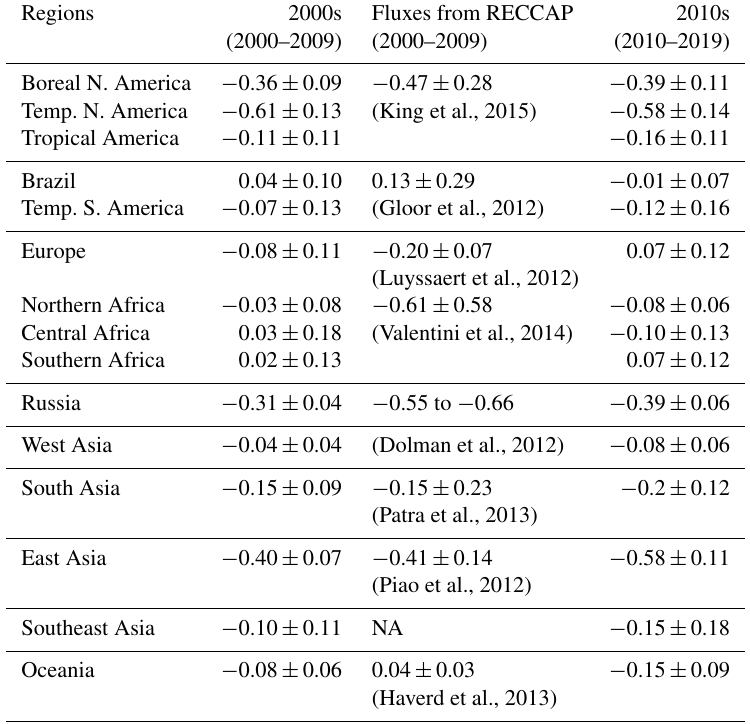
Table 4. Mean ± 1 σ standard deviation of annual net land–atmospheric exchange of CO 2 (in PgCyr − 1 ) from predicted fluxes for 15 land regions by decade. The predicted fluxes are shown for the best estimates, obtained from the ensemble mean of all 16 inversion cases based on different priors (gc3t and gvjf) and uncertainties (MDU and PFU). The ± 1 σ in the decadal mean fluxes denotes the range of uncertainty. The estimations for the 2000s are compared with the REgional Carbon Cycle Assessment and Processes phase 1